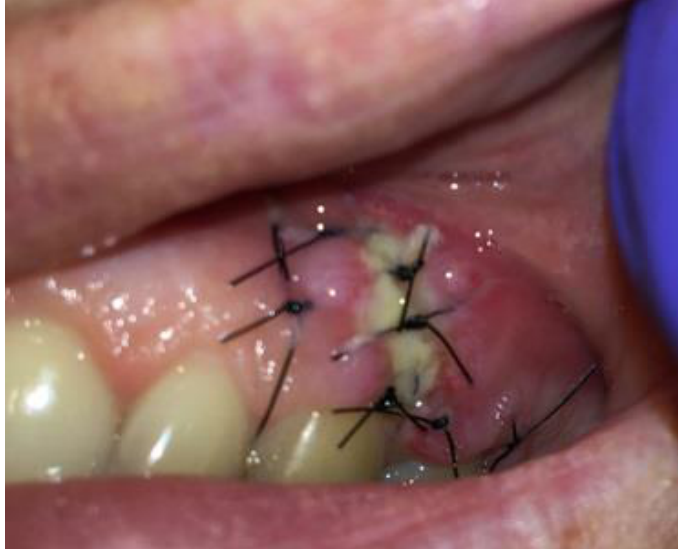
Figure 9. Intraoral photograph 7 days after surgery.